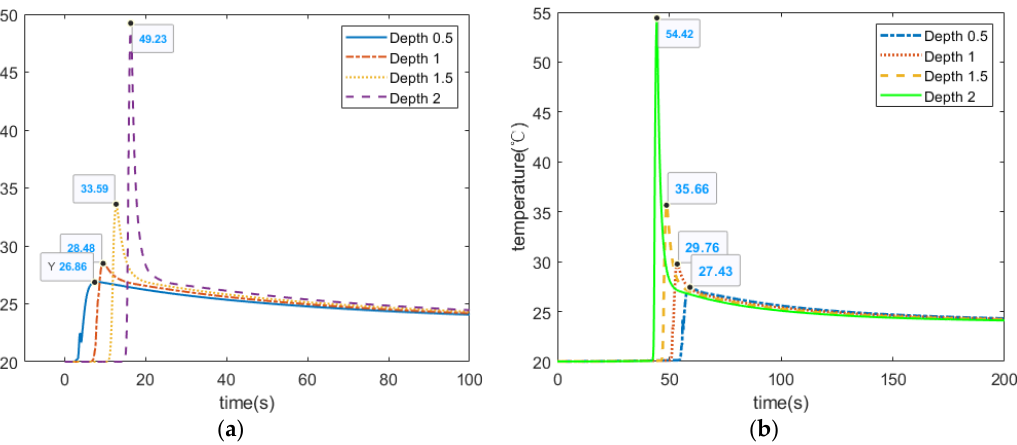
Figure 6. Temperature simulation of impact damage. ( a ) Temperature simulation of 3 mm diameter defects. ( b ) Temperature simulation of 5 mm diameter defects.